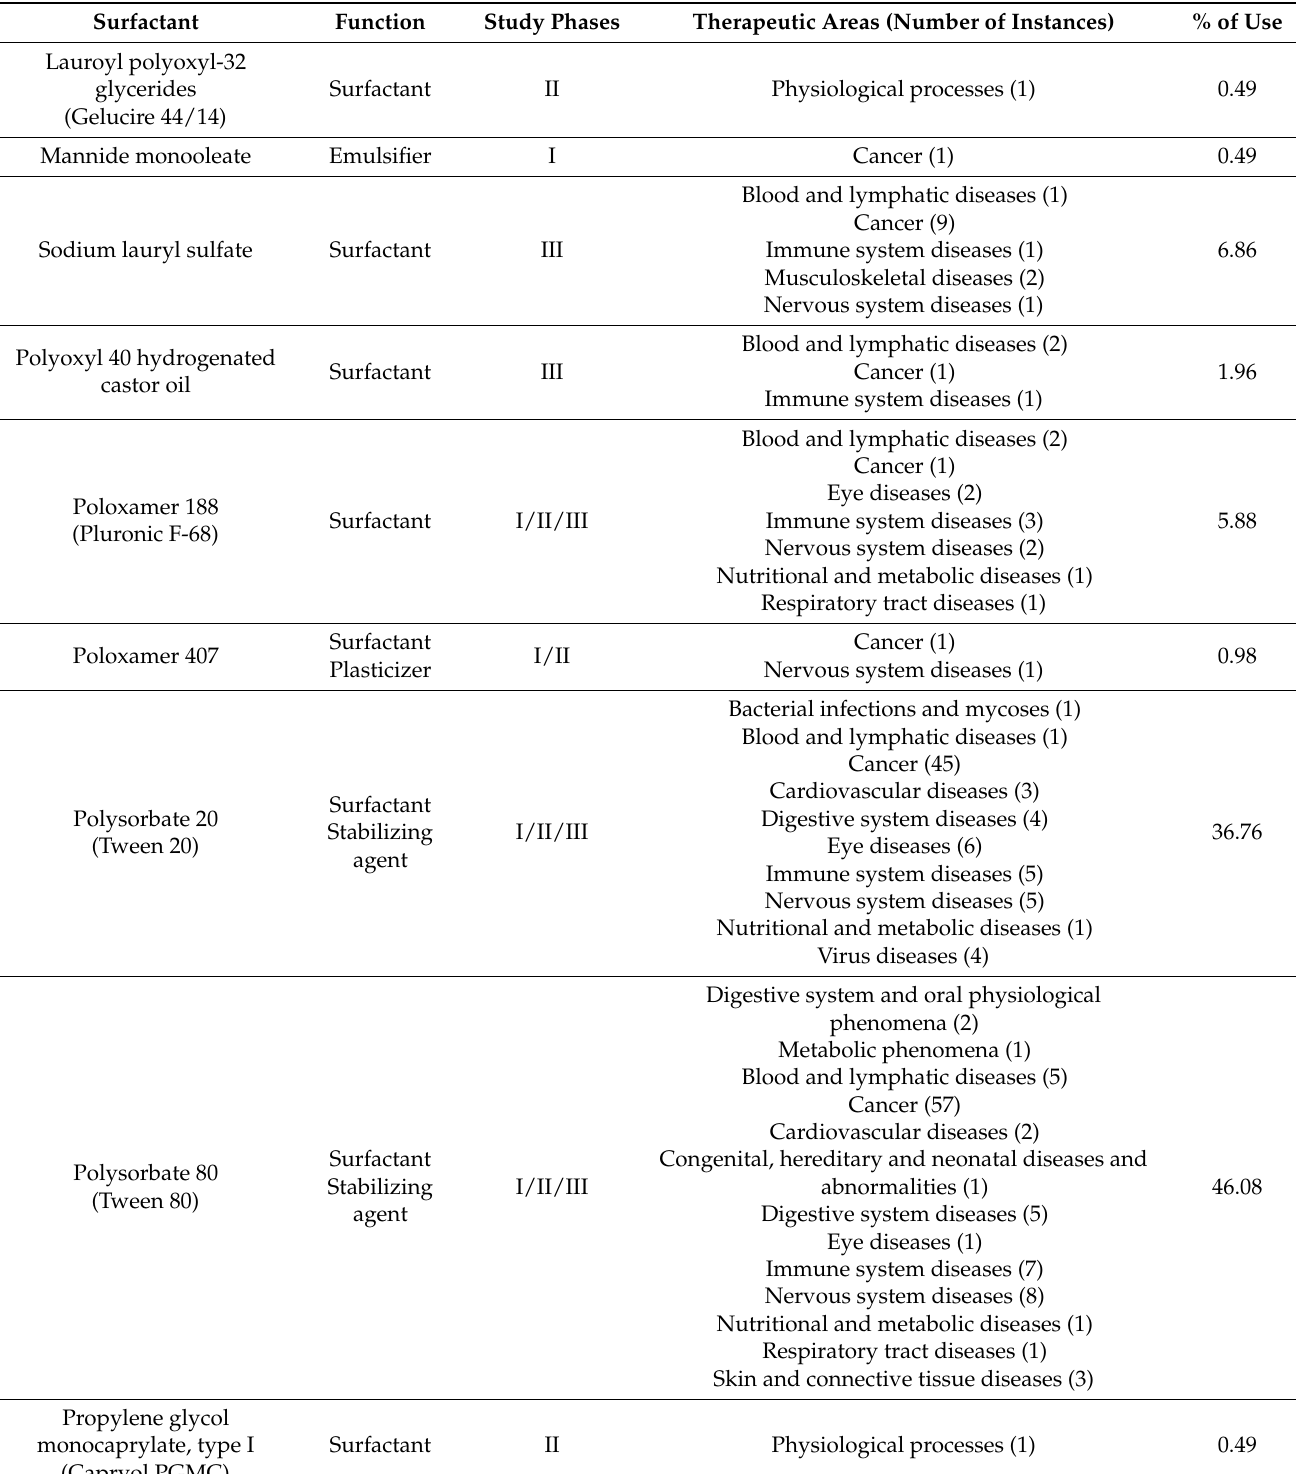
Table 1. Surfactants described in the Investigational Medicinal Product Dossiers